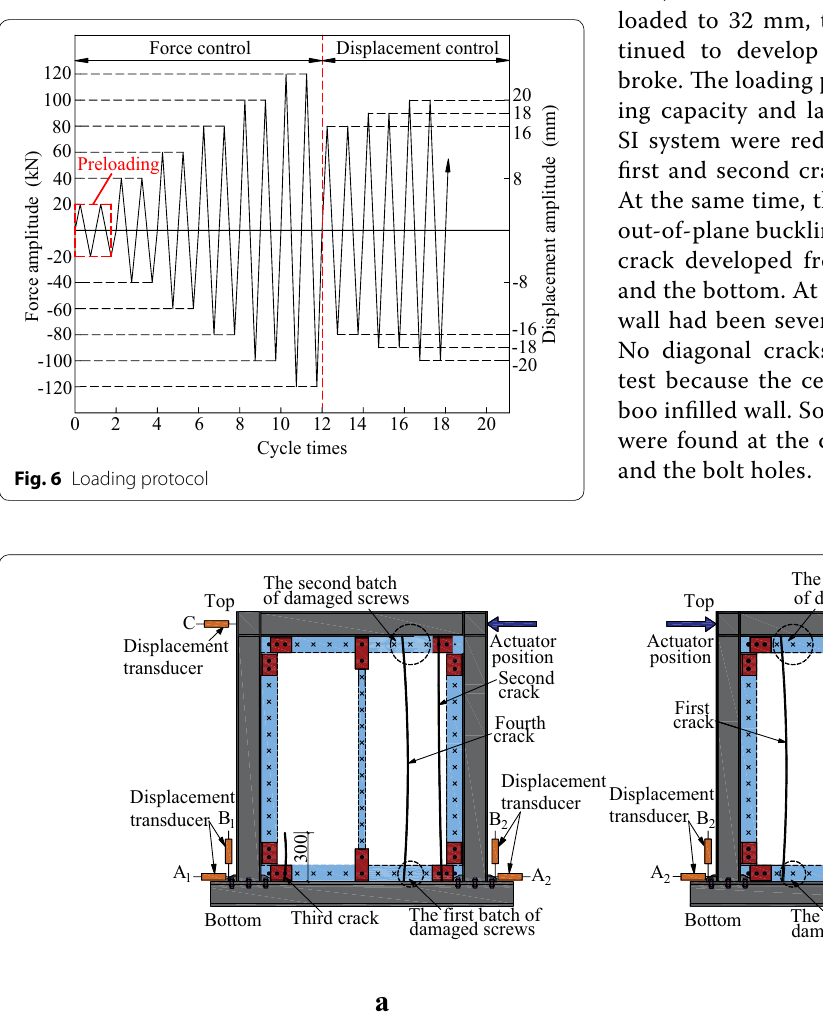
Fig. 7 Cracks’ distribution: a front view and b back